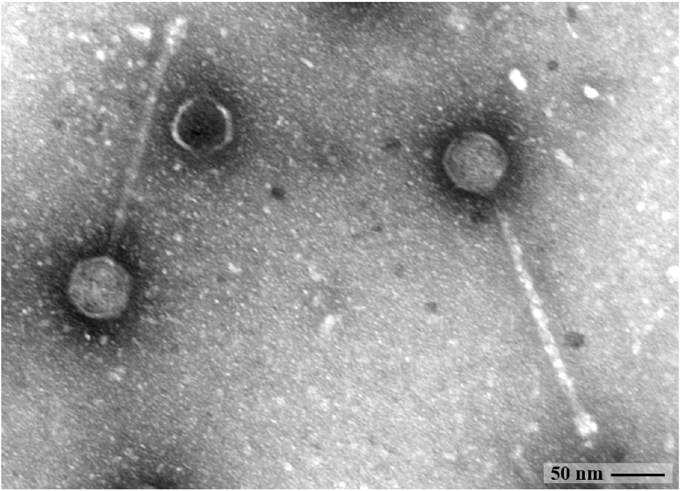
Figure 1. TEM image of the phage CUB-EPI_14 virions. Phage head (59 nm diameter) and tail (238 nm length and 10.7 nm width) measurements were determined with the image processing software ImageJ.JS [16].